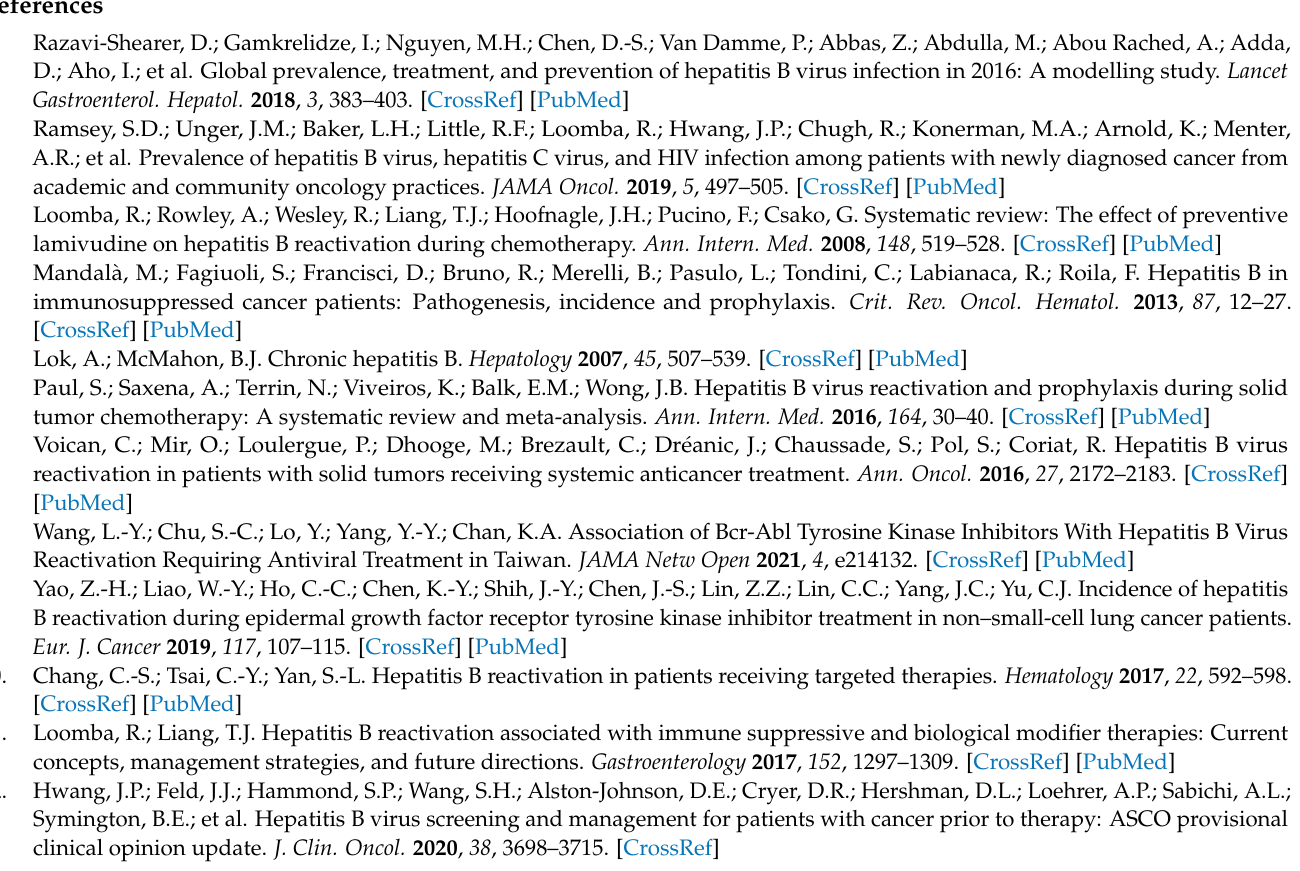
tyrosine kinase inhibitor treatment with and without HBV